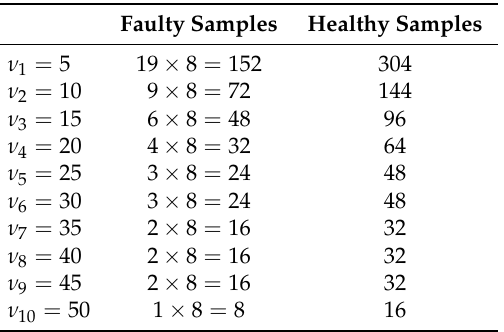
Table 11. For each scenario, we will study a different number of faulty and healthy samples of ν = ν i , i = 1, . . . ,10 elements